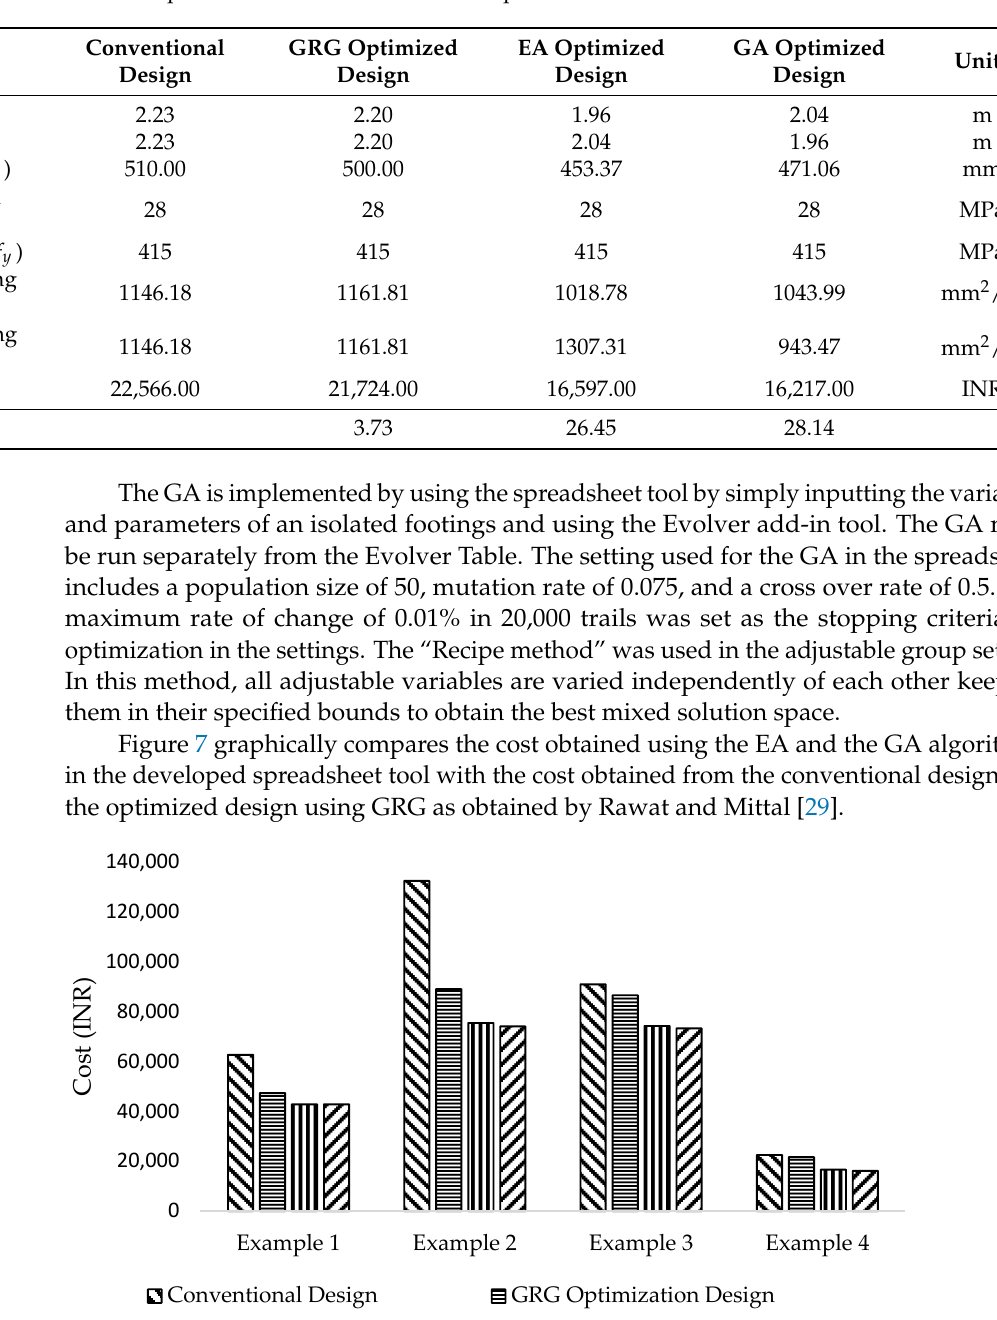
Table 7. Optimum values obtained for example 4.